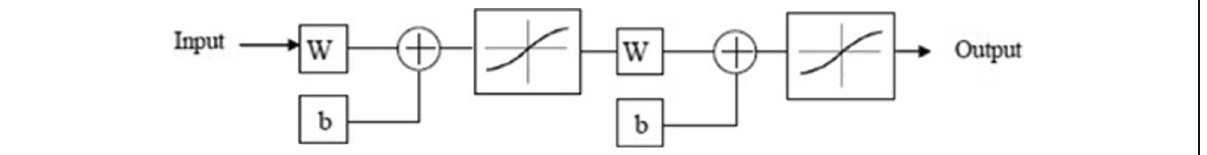
Fig. 14 Neural network